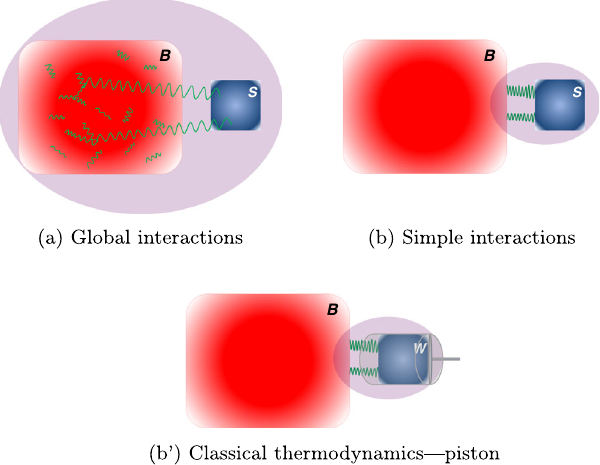
FIG. 1. Thermal operations versus crude operations versus classical operations. We consider a heat bath B together with a system S or working body W and illustrate the different levels of control an experimenter can have on the setup and interactions. (a) The most detailed, experimentally unfeasible control where the experimenter keeps a record of every microstate of the system and bath (the area contained within the purple oval) and controls interactions between the system and the entirety of the heat bath (illustrated by green stings). (b) The desired level of control where the experimenter keeps track of the system and a small portion of the bath (purple oval) and performs some simple interactions between these regions (green strings). (b 0 ) The previous case can be regarded as analogous to the setup in traditional thermodynamics where one has a working body W of which some parameters can be changed using simple processes such as moving a piston and weak couplings to the heat